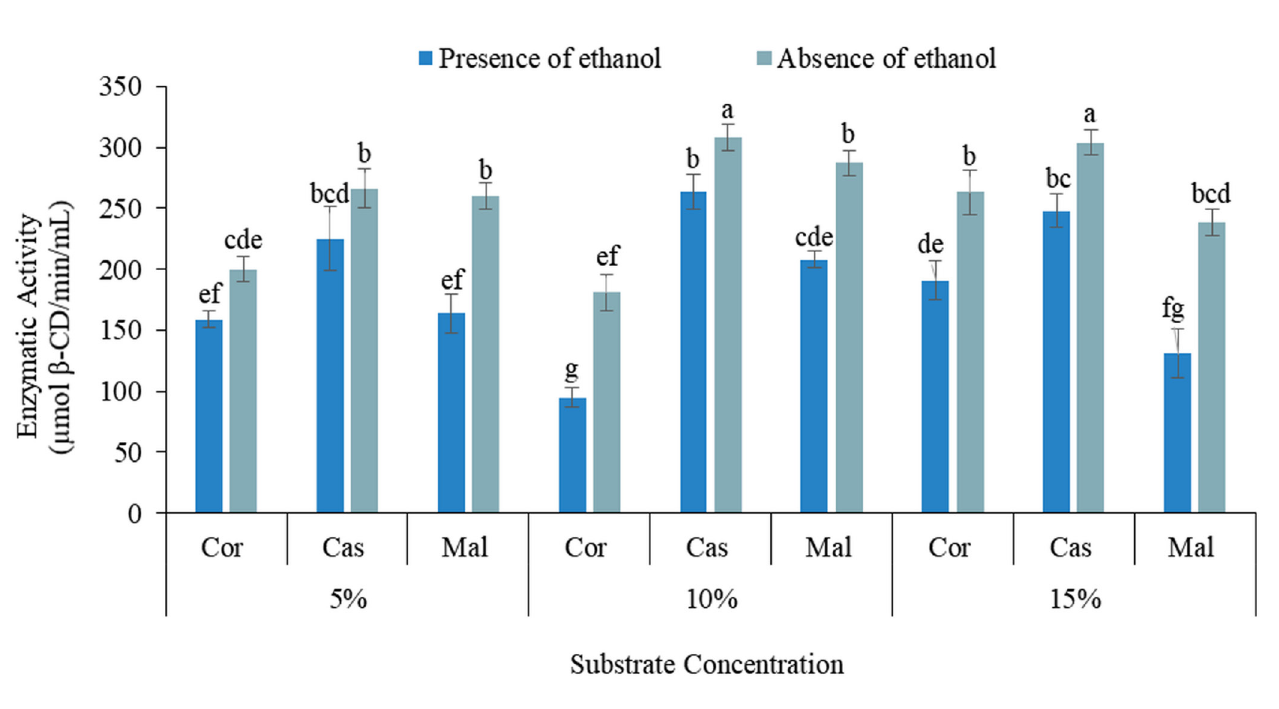
FIGURE 1 - Determination of most effective substrate and the influence of ethanol on β -CD production using corn starch (Cor), cassava starch (Cas) and maltodextrin (Mal) at concentrations of 5, 10 and 15% (w/V) in 10% (V/V) 10 mM sodium citrate buffer pH 6.0, in the presence and absence of 10% ethanol (V/V) and 0.02% enzyme (V/V). The reaction lasted 60 min at 65 °C. Spectrophotometric data were obtained for the β -CD dosages by the phenolphthalein